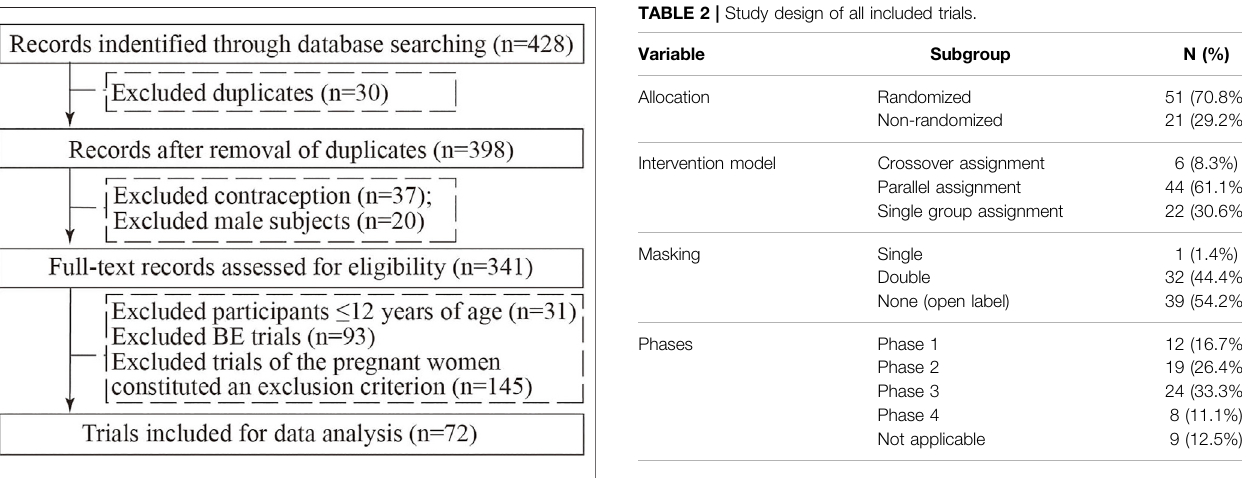
FIGURE 1 | Flowchart of selection trials.